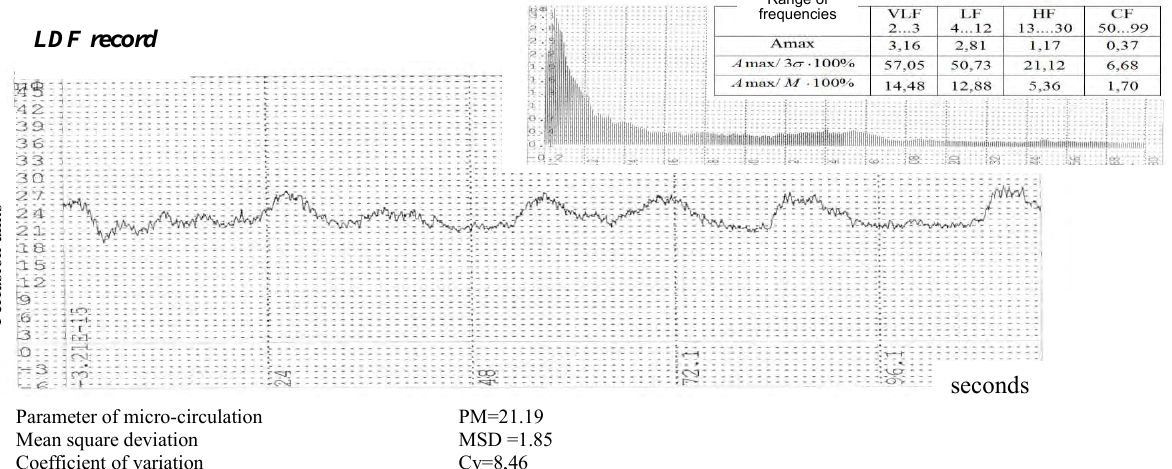
Parameter of Fig.4. Daily monitoring of LDF record of 17 years old girl with standard type of micro-circulation at 7 p.m.